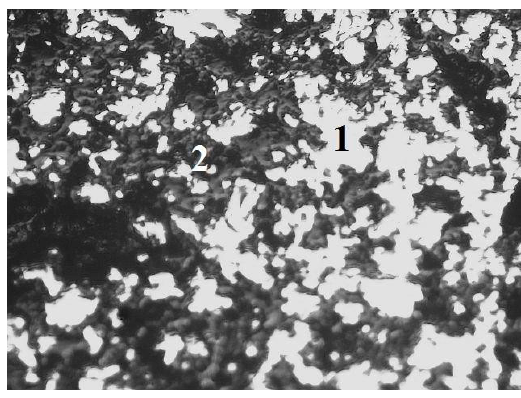
Figure 9. Optical microscopy of the reduced lime-bonded brex (1—iron, 2—Mellilite; magnification 200).